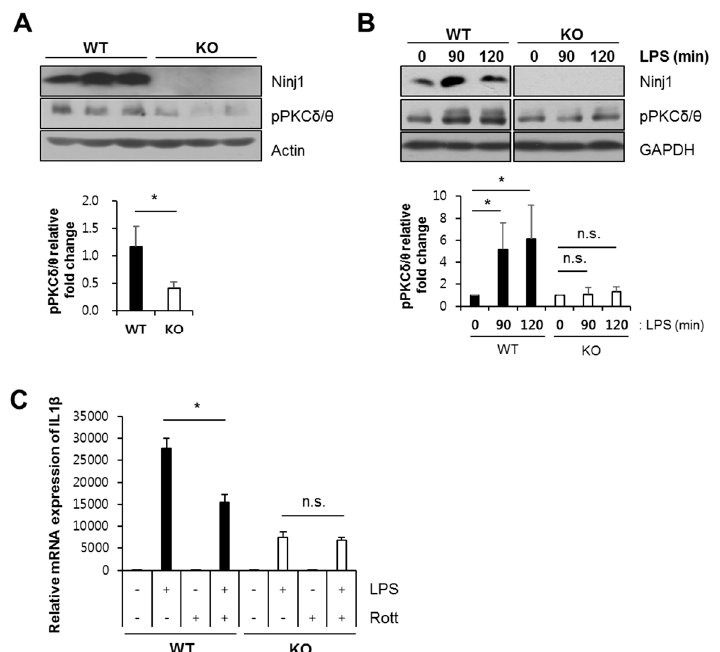
Figure 8. The PKC δ / θ activation is regulated by Ninj1 in macrophages. ( A ) Immunoblot analysis of Ninj1, pPKC δ / θ , and Actin performed on colonic tissues extracted from 1.5% DSS-treated WT and Ninj1 KO mice; n = 3 per group. Densitometry represents relative protein levels of pPKC δ / θ . Values presented are mean ± SD. * p < 0.05, Student’s t -test. ( B ) WT and Ninj1 KO Raw264.7 cells were treated with 0.5 µ g / mL of LPS for 2 h. Western blot analysis was performed to detect the expression of Ninj1, pPKC δ / θ , and GAPDH. Densitometry represents relative protein levels of pPKC δ / θ . n.s., not significant. Values presented are mean ± SD. * p < 0.05, Student’s t -test. Similar results were observed in three independent experiments. ( C ) WT and Ninj1 KO Raw264.7 cells were treated with 5 µ g / mL of rott (rottlerin) and LPS (0.5 µ g / mL) for 6 h. qRT-PCR was performed to detect mRNA expressions of IL1 β . Data are presented as mean ± SEM. * p < 0.05, Student’s t -test. Similar results were observed in three independent experiments.